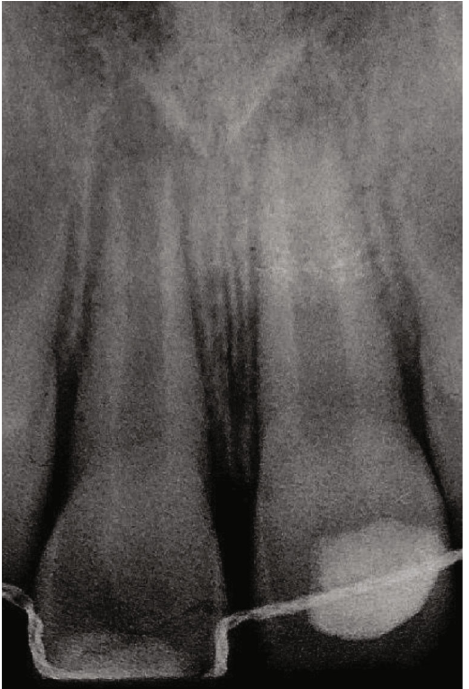
Figure 1: Retroalveolar radiograph. The tooth had immature roots (Nolla ’ s stage 8).